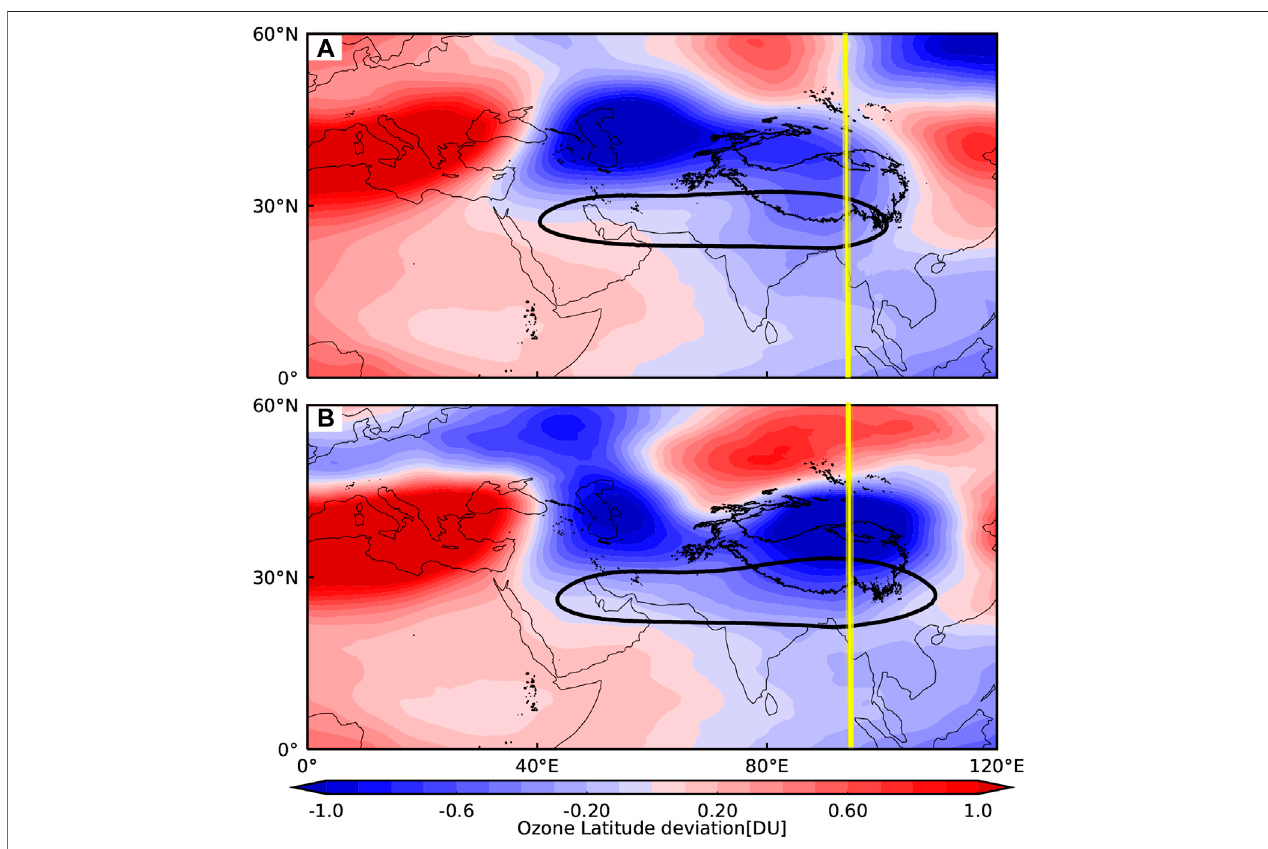
FIGURE 13 | The composite TCO* (shading, unit: DU) and the SAH region (solid lines, 12,520 gpm geopotential height isolines) for the EOF time series 3 in the (A) stronger years and (B) weaker years. The yellow lines are the longitude of 95 ° E.